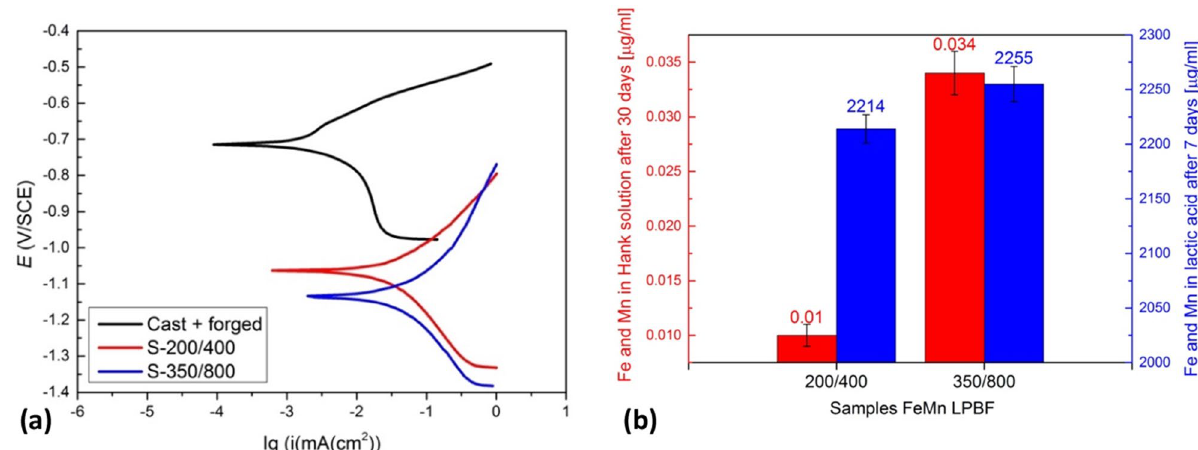
Figure 6. Corrosion results with potentiodynamic measurements of samples S-200/400 and S-350/800 compared with the cast and forged sample with a similar chemical composition measured in Hank’s solution ( a ) and total concentration of Fe and Mn after the static immersion tests of samples S-200/400 and S-350/800 performed in 0.1 M lactic acid and Hank’s solution at 37 °C ( b